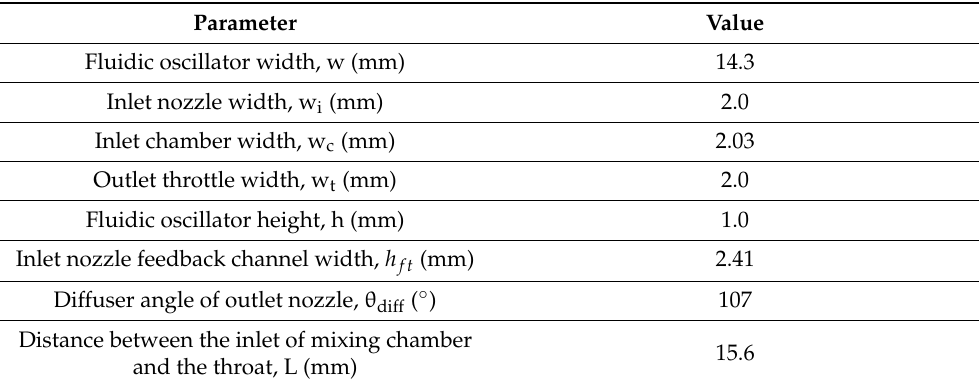
Figure 3. Installation location of fluidic oscillators.